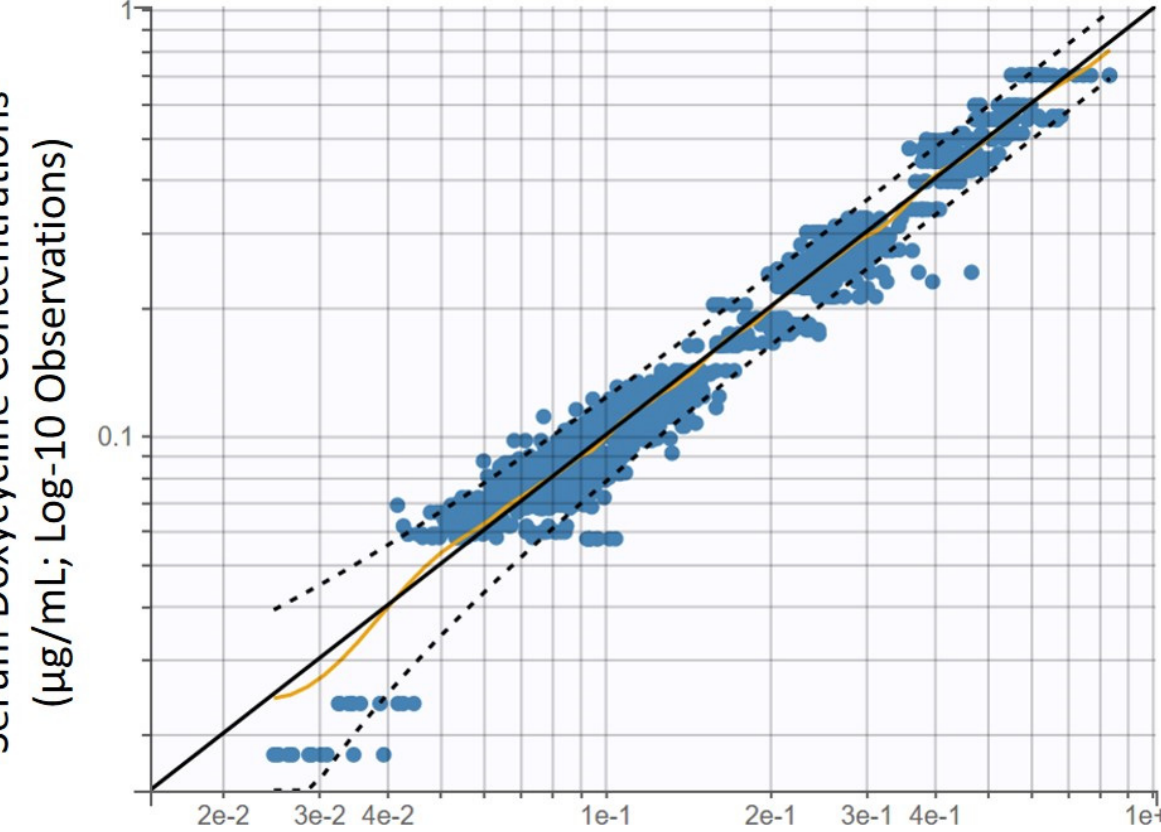
Figure 1. Predictive performances and robustness of fit of the final pharmacokinetic model of serum doxycycline concentration following administrations of 10 mg/kg doxycycline PO q12 h in 8 healthy jennies. Blue dots: observations; solid tan line, identity line; dotted black lines: 90% prediction interval.